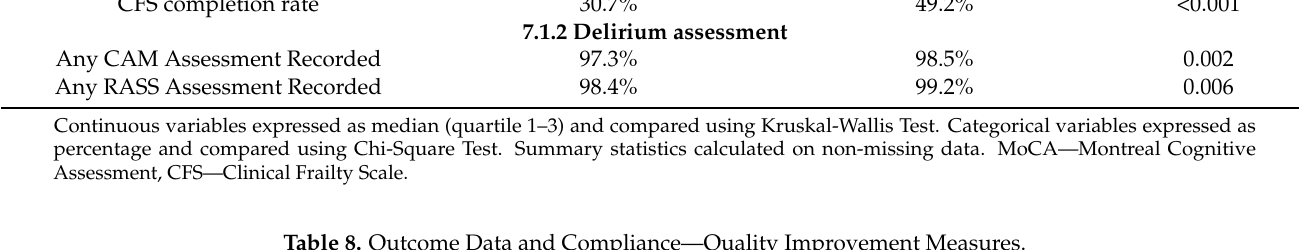
Table 8. Outcome Data and Compliance—Quality Improvement